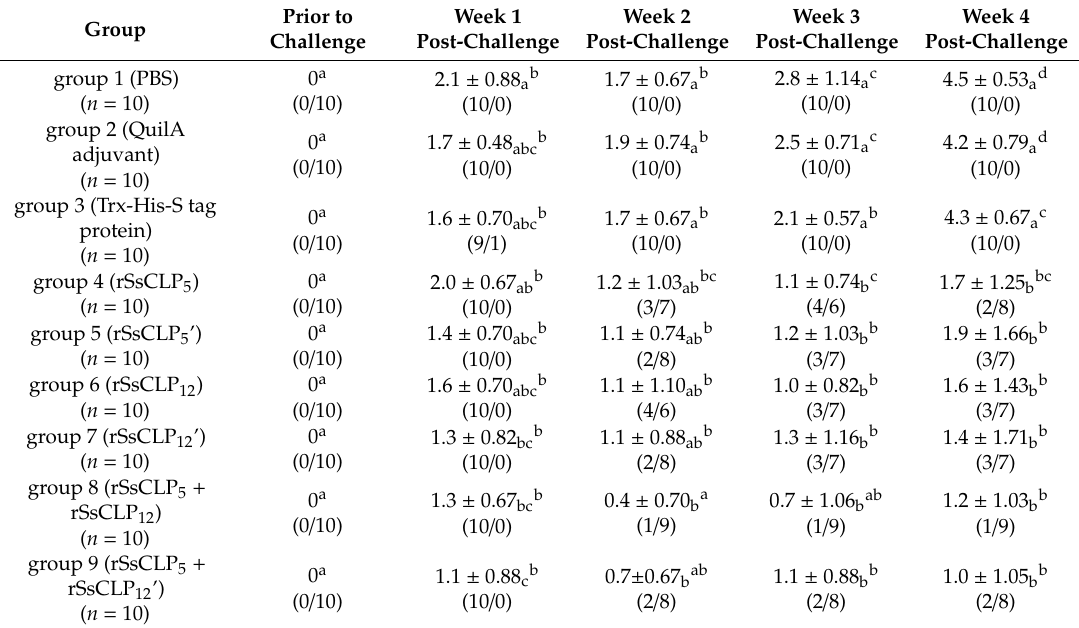
and asymptomatic rabbits after challenged with S. scabiei .